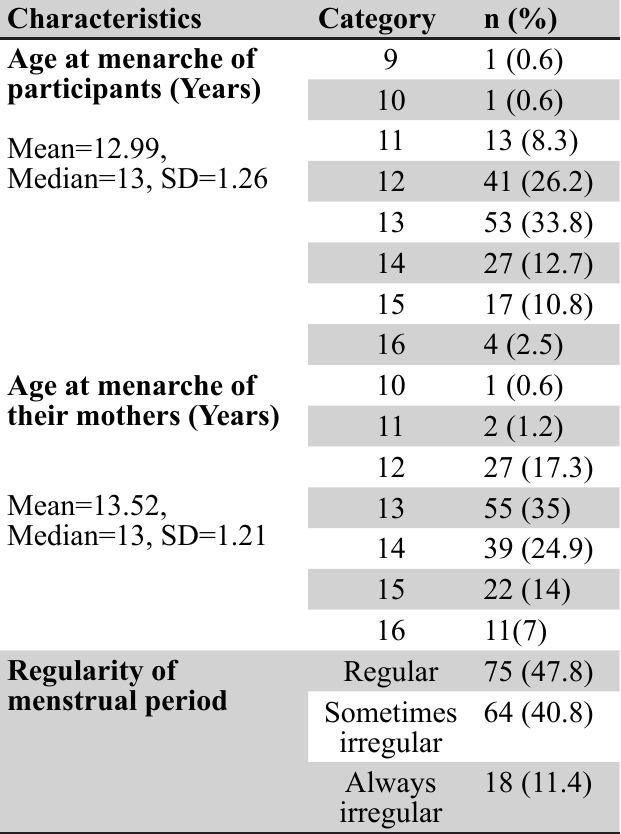
Table 1: Baseline characteristics of the study participants